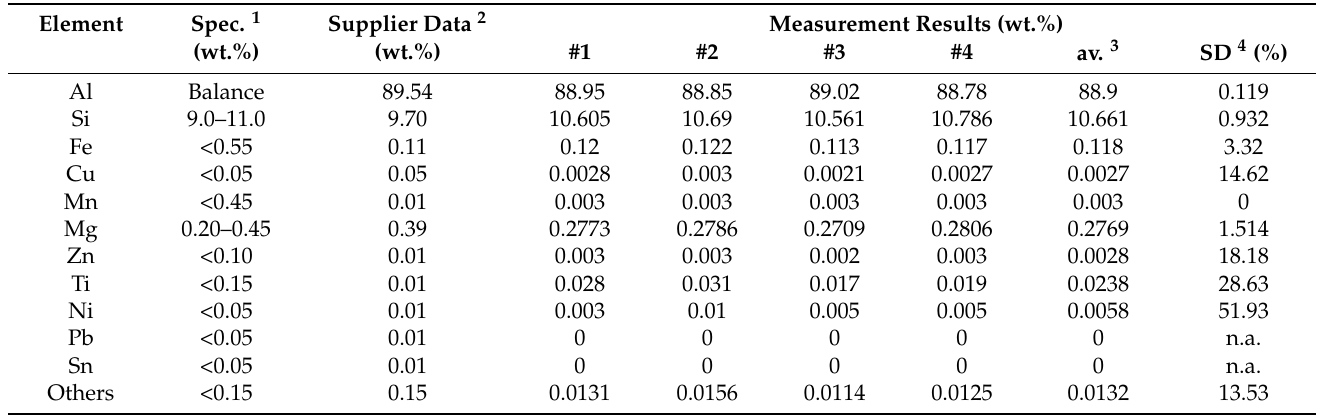
Table 1. Chemical composition of the AlSi10Mg powders and samples according to specification [43], supplier measurements and as determined on printed samples by OES.